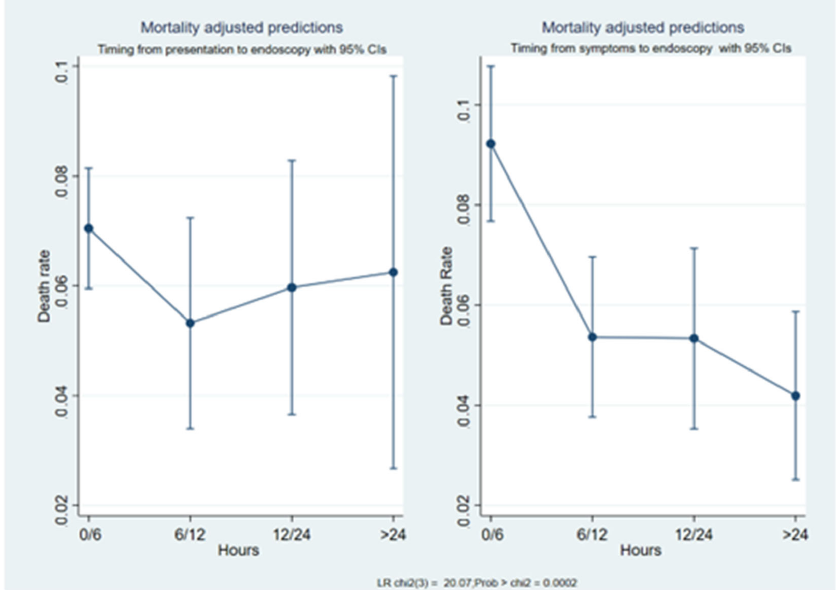
Figure 1. The mortality prediction according to the two timeframes.